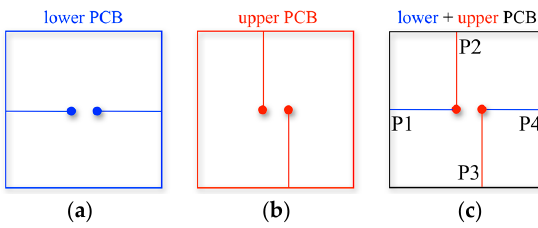
Figure 24. Concept of planar BGA contact pad assembly from Figure 23. ( a ) lower PCB ( b ) upper PCB ( c ) lower+upper PCB